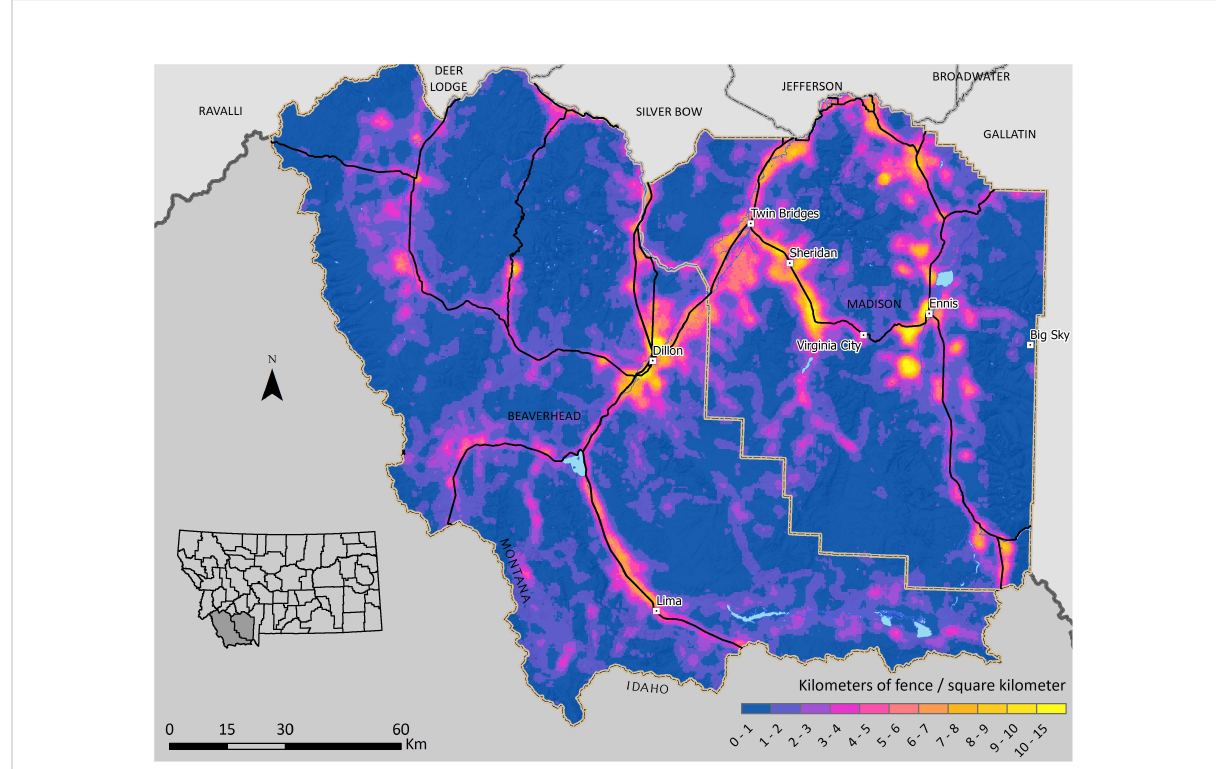
FIGURE 2 Modeled fence density in Beaverhead and Madison Counties, Montana. The mean fence density was 0.93 km/km2 with a maximum density of 14.9